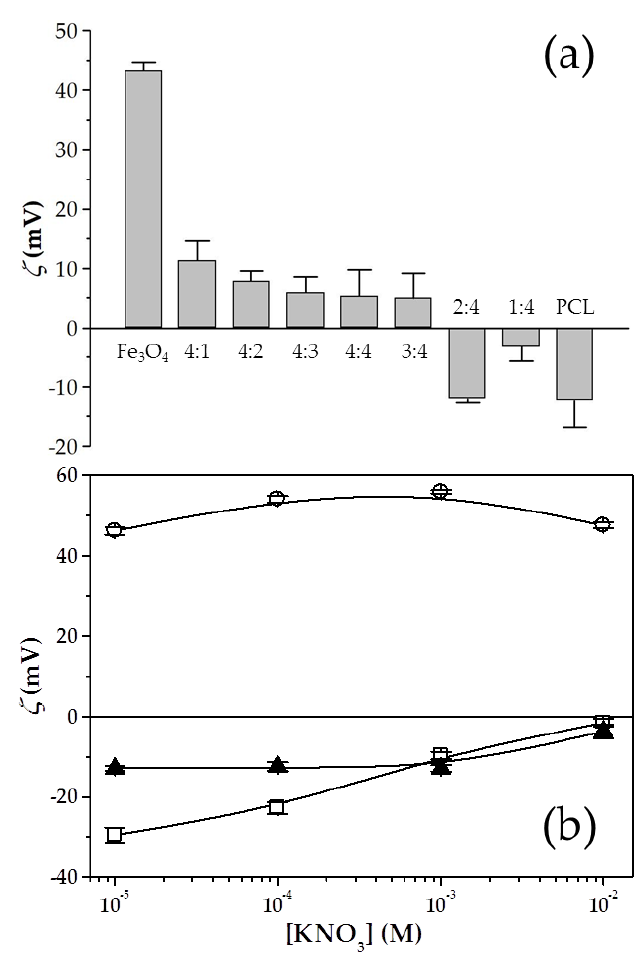
Figure 2. ( a ) Zeta potential ( ζ , mV) of the nanocomposites of Fe 3 O 4 :PCL weight proportions ranging from 4:1 to 1:4, Fe 3 O 4 NPs, and PCL NPs, in water (pH ≈ 6) , and ( b ) zeta potential ( ζ , mV) of Fe 3 O 4 from 4:1 to 1:4, Fe 3 O 4 NPs, and PCL NPs, in water (pH ≈ 6), and ( b ) zeta potential ( ζ , mV) of Fe 3 O 4 NPs ( ○ ), PCL NPs ( □ ), and Fe 3 O 4 /PCL NPs ( ▲ , of 2:4 Fe 3 O 4 :PCL weight ratio) as a function of the NPs ( ), PCL NPs ( (cid:3) ), and Fe 3 O 4 / PCL NPs ( (cid:78) , of 2:4 Fe 3 O 4 :PCL weight ratio) as a function of molar concentration of KNO 3 at pH ≈ 6. Lines are a guide to the eye and have no other significance. (cid:35)